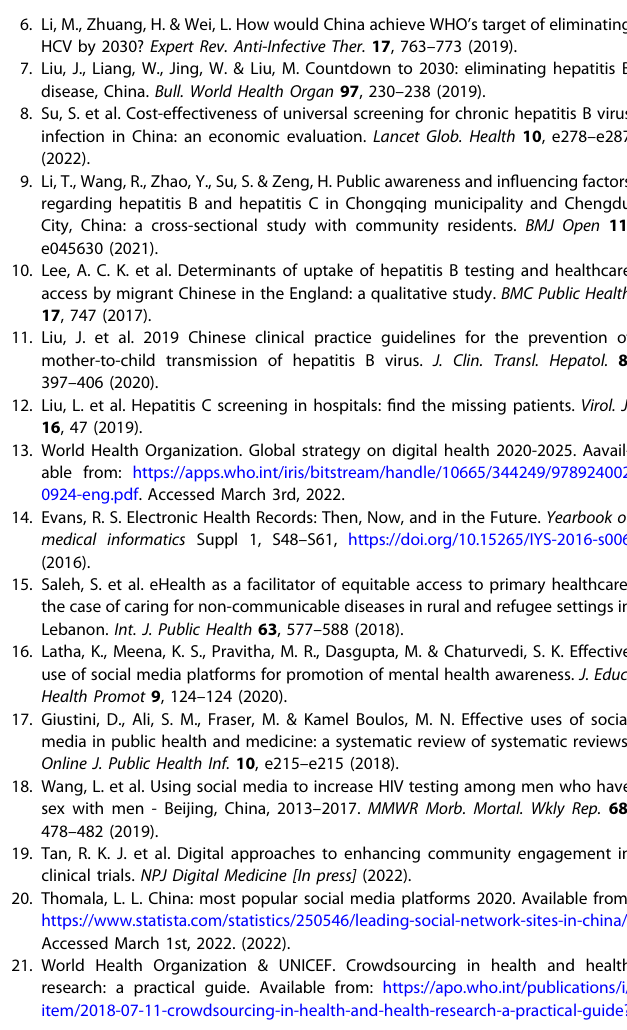
Fig. 3 Digital dissemination of digitally crowdsourced intervention materials. Flowchart showing the process of distributing crowdsourced HBV and HCV testing promotion using social media and accessing hepatitis testing services using the ‘ Smart hospital ’ online application. Left diagram: digital dissemination cycle of the crowdsourced intervention materials; Right: Honk Kong University Shenzhen hospital online service application platform